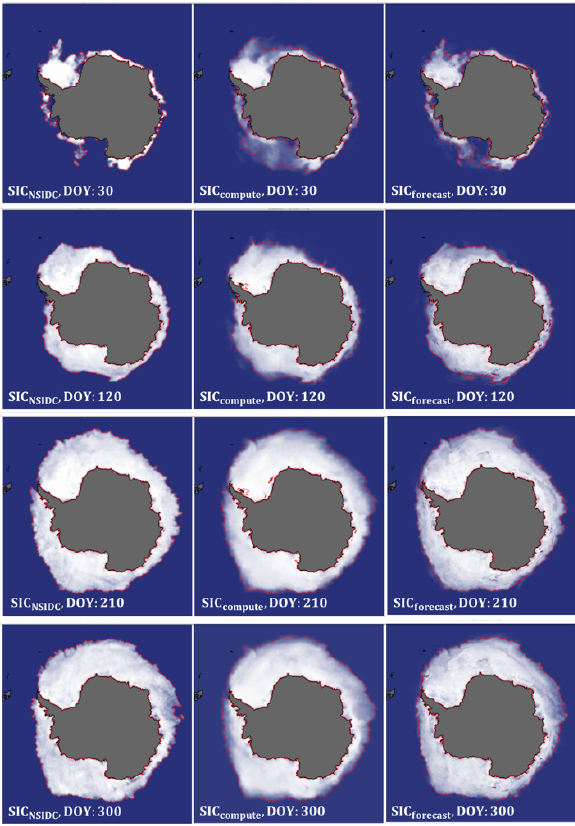
Figure 1. Daily SIC comparisons between the original and reconstructed